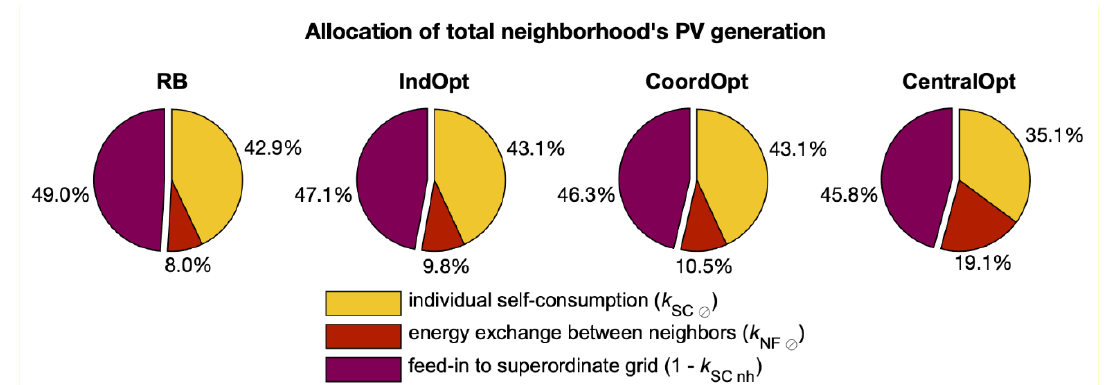
Figure B1. Allocation of the total neighborhood’s PV generation for the investigated EM concepts. Figure A1. Allocation of the total neighborhood’s PV generation for the investigated EM